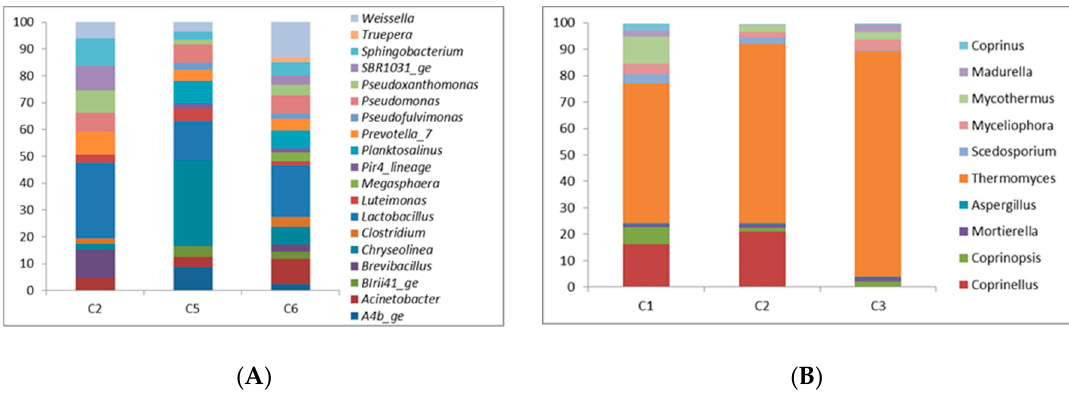
ff erent genera of bacteria ( A ) and fungi ( B ) in the three Figure 1. Relative abundance of different genera of bacteria ( A ) and fungi ( B ) in the three composts. Figure 1. Relative abundance of di